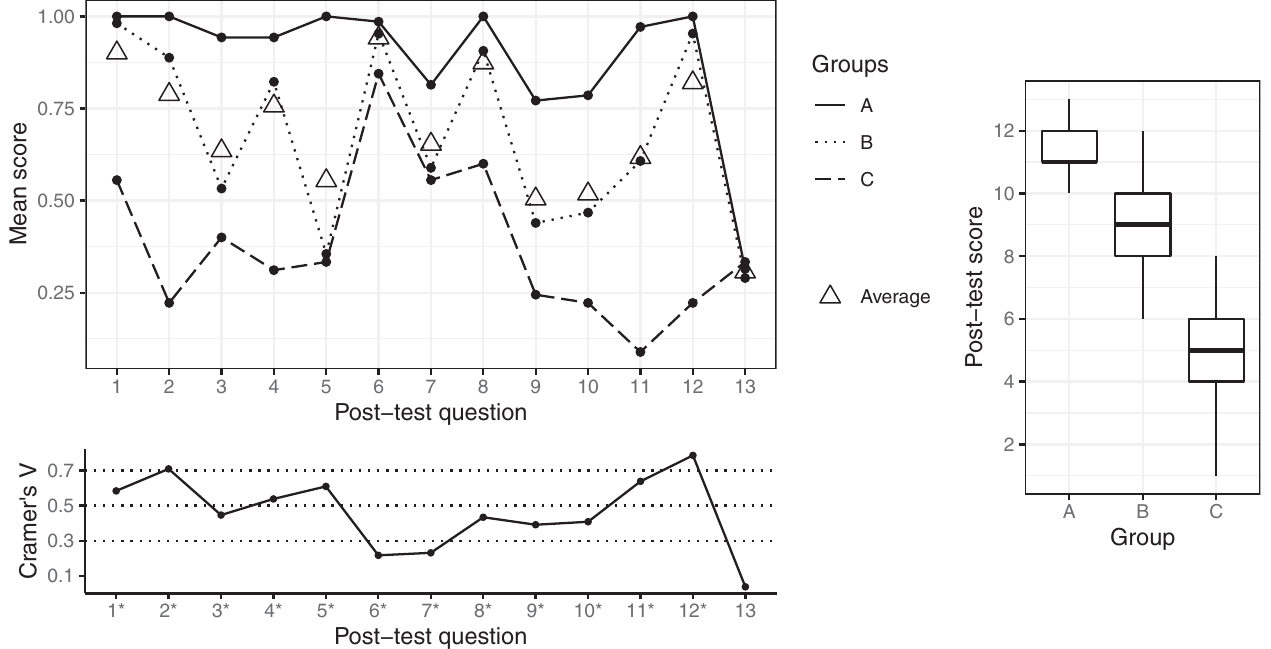
FIG. 2. Item-wise and total post-test scores by LCA group. Top left: item-wise averages for group A (solid line), group B (dotted line), group C (dashed line), and overall average (triangle). Bottom left: Cramer ’ s V (effect size) for intergroup score differences. Significant differences are marked with * . Right: boxplots of post-test scores by